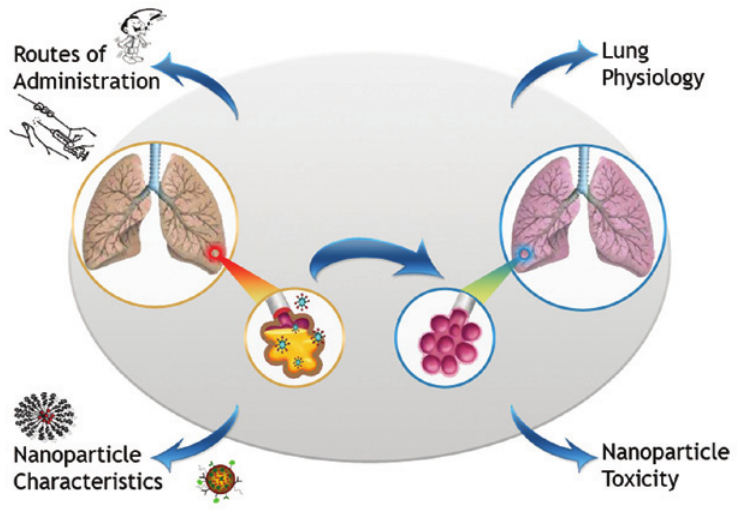
Figure 1 - Factors that can influence nanoparticle drug